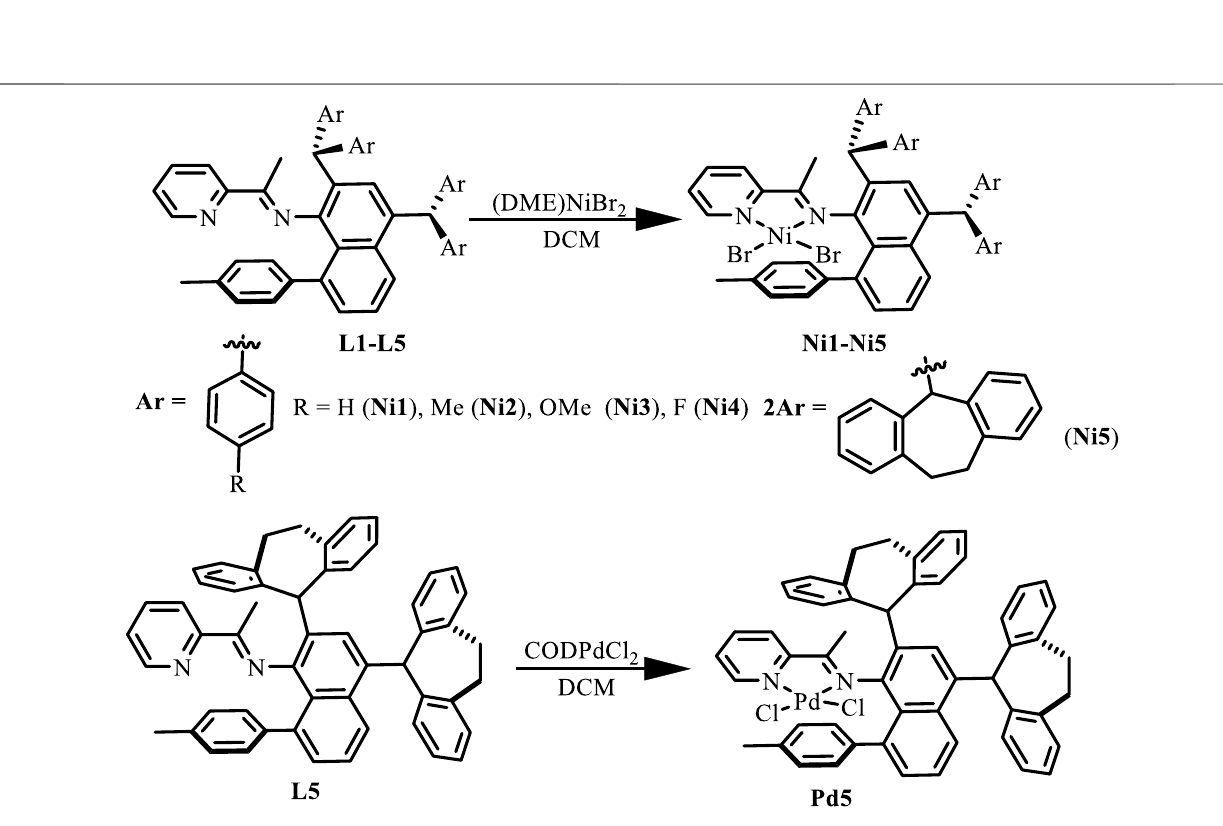
Frontiers in Chemistry |